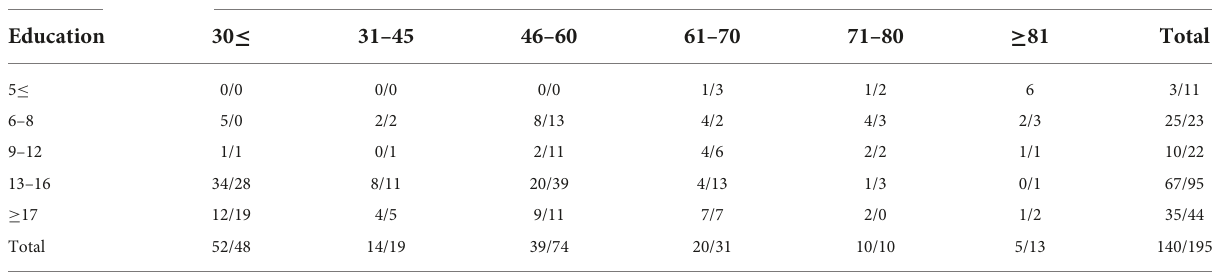
TABLE 1 Sample stratification for age, education, and